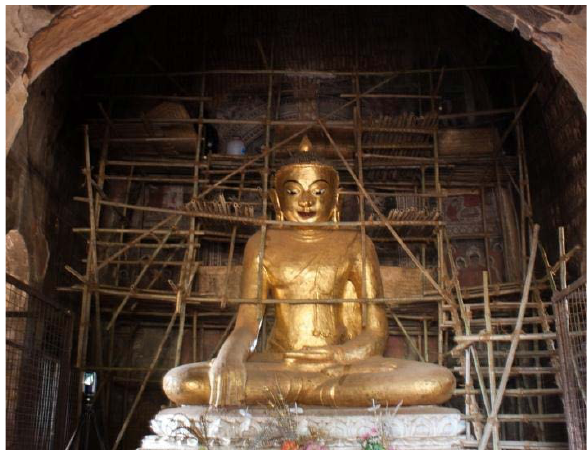
Figure 3. Scaffolding in central shrine of Loka-Hteik-Pan following the 2016